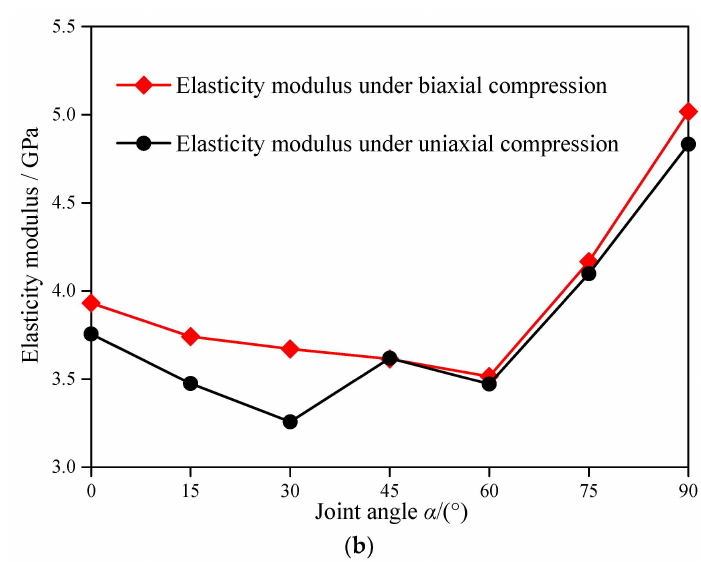
Figure 5. Mechanical parameters of specimens with different dip angles under uniaxial and biaxial compressions. ( a ) Strength comparison under uniaxial and biaxial compressions; ( b ) Elasticity modulus comparison under uniaxial and biaxial